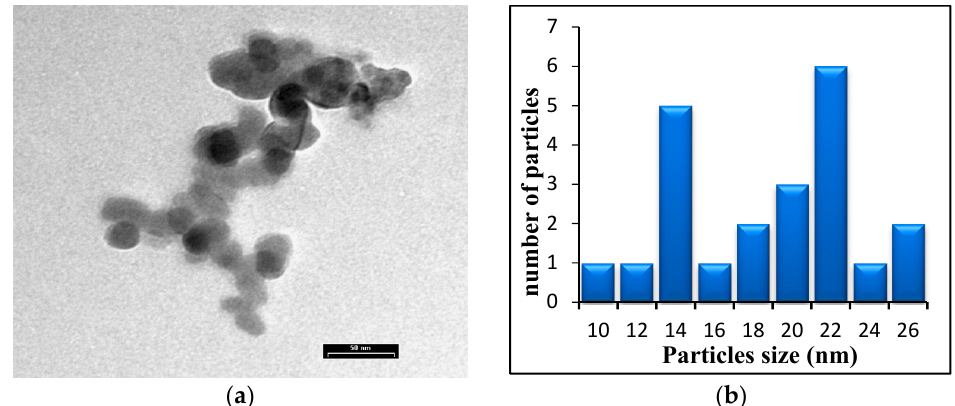
Figure 6. ( a ) TEM image of TiO 2 NPs prepared at the following laser conditions (80 mJ; 10 min) and